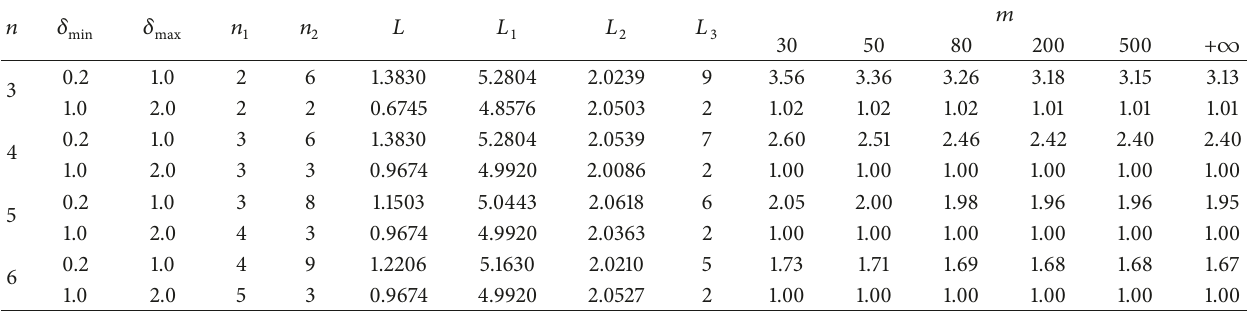
Table 1: Optimal charting parameters (𝑛 1 , 𝑛 2 ,𝐿,𝐿 1 ,𝐿 2 ,𝐿 3 ) and the corresponding EARL 1 s for 𝑛 = {3,4,5,6} with different combinations of (𝑚,𝛿 , 𝛿 ) when EARL = 370.4 . min max 0